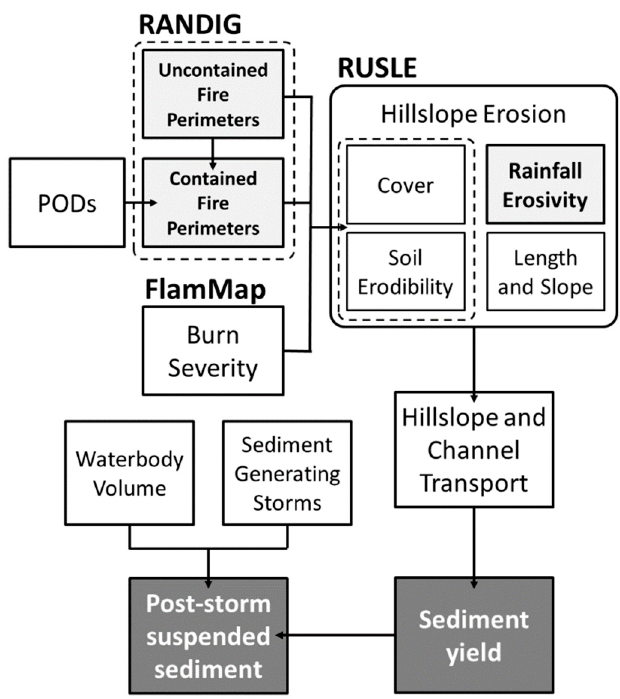
Figure 1. The evaluation framework focuses on total sediment yield and average post-storm suspended sediment as measures of water quality degradation risk. Variable inputs are in light grey. Stochastically simulated wildfire perimeters were combined with estimates of burn severity to model post-fire erosion and sediment transport to the water supply both with and without containment. Sediment yield was converted to average post-storm suspended sediment concentration using the receiving waterbody volume and the annual frequency of sediment generating storms.